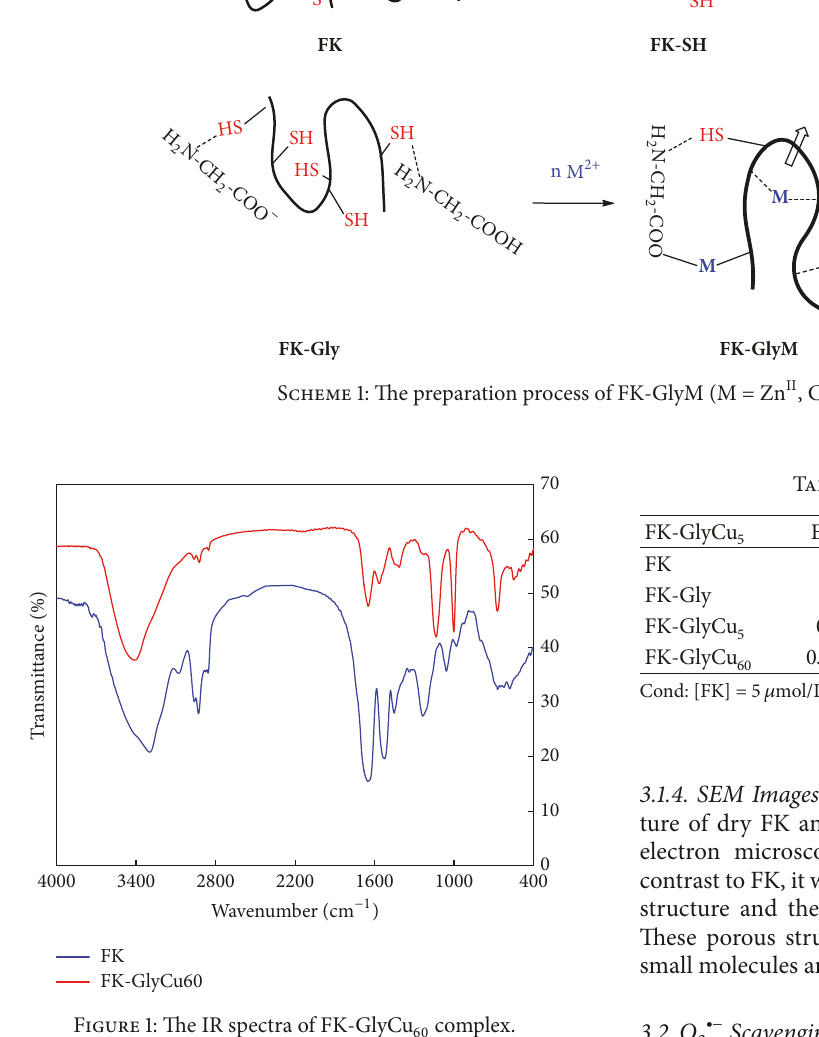
stability of the obtained keratin-glycine metal complexes was reduced.